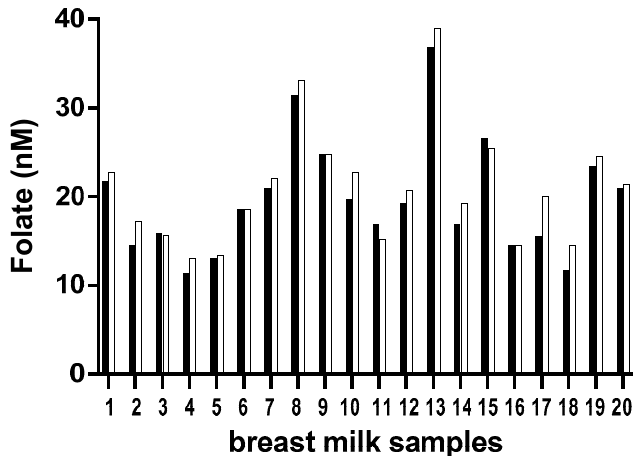
Figure 3. Apparent stability of folate levels in breast milk during prolonged storage (18 months at − 80 ◦ C) The same 20 breast milk samples were measured in November 2015; black bars) and in May 2017 (open bars) with the modified FOLA method described in this manuscript.